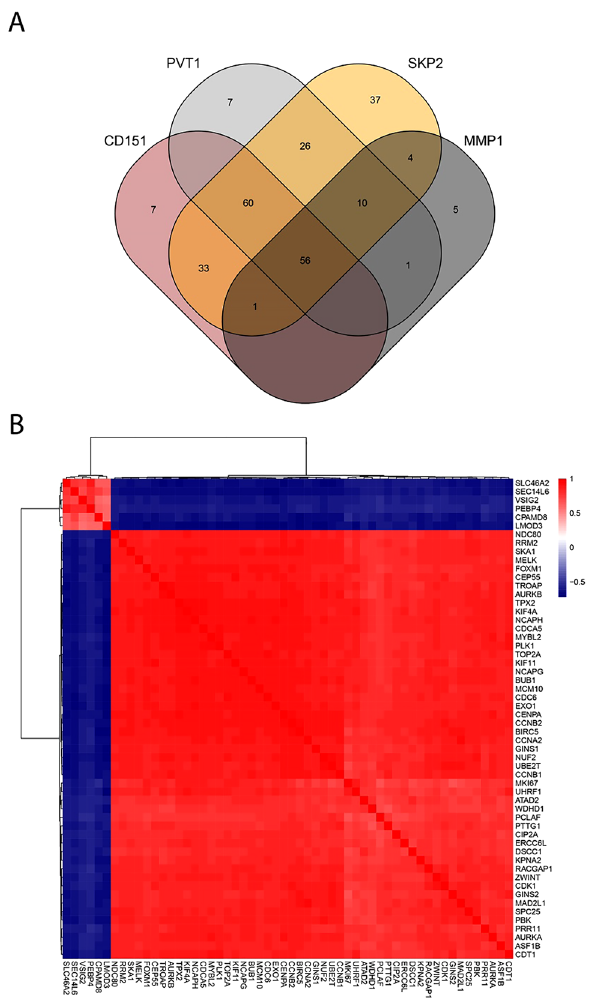
Figure 4. Genes that are significantly expressed differentially between N + and N0 compared to normal, which were also significantly expressed differentially in N + compared to N0. ( A ) Venn diagram of the significantly correlated DEGs with the reference genes, ( B ) 56 candidate genes are significantly correlated with CD151 , MMP1, PVT1, and SKP2 and divided into two